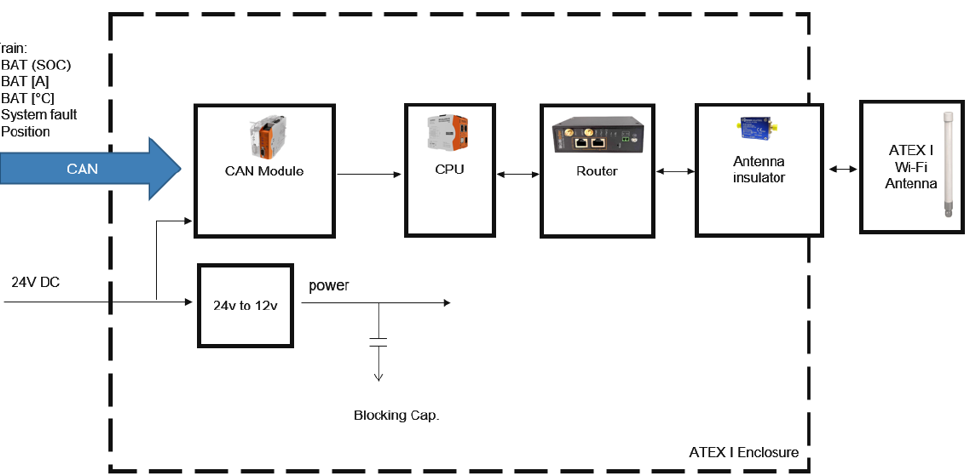
Figure 10. Conceptual block diagram of the monitoring module of the suspended tractor developed within the HEET II project. The CPU collects data from the power system of the suspended tractor via a CAN interface, and transmits them via the network created by the access points.